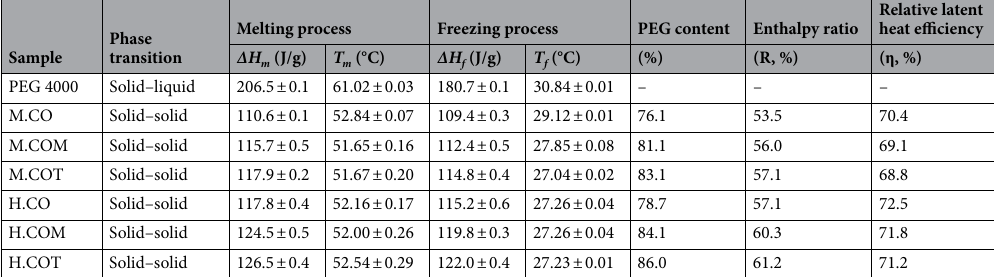
Table 2. Phase-change characteristics of the SSPCMs calculated from 5 consecutive DSC scans.